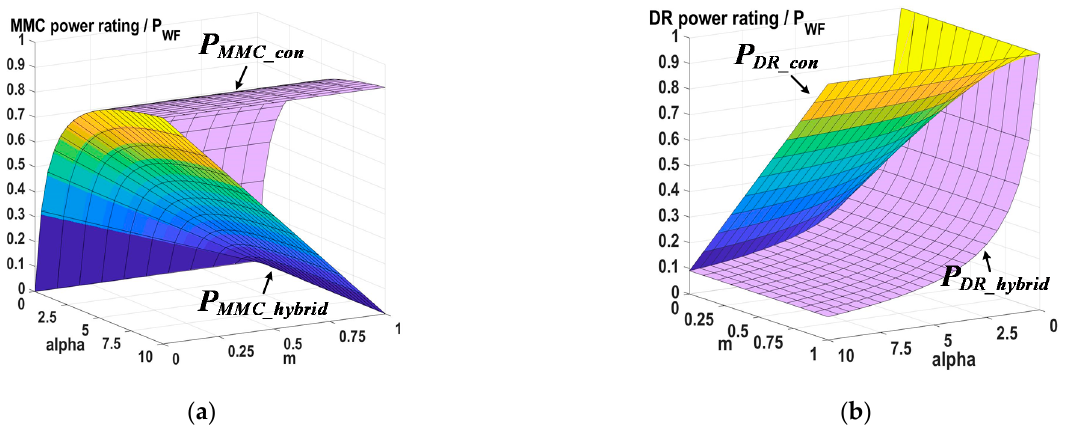
Figure 2. Converter power ratings for different system configurations versus different power ratio α and DC voltage ratio m: ( a ) MMC power rating; ( b ) DR power